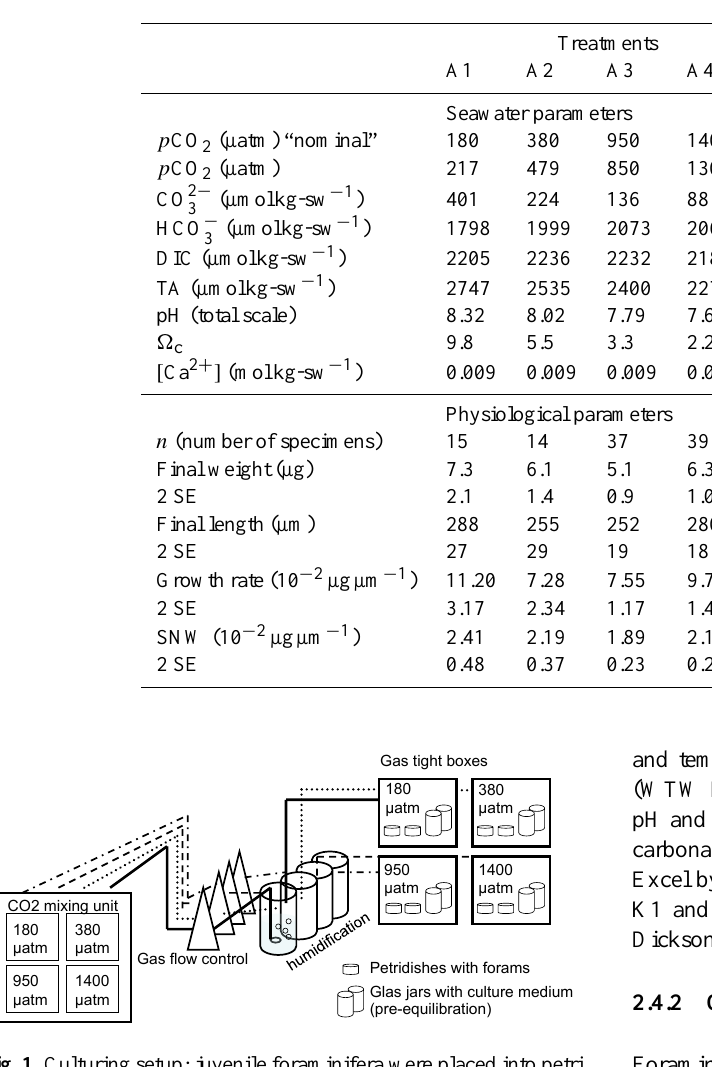
Table 1. Upper part: calculated and measured carbonate chemistry parameters of the eight treatments. “Nominal” p CO 2 refers to the p CO 2 supplied by the gas mixing system. A variety of input parameters (here pH and DIC) can be used to calculate the carbonate system and can be found in the supporting online material of Keul et al. (2013). Lower part: mean physiological parameters and 2SE (standard errors).